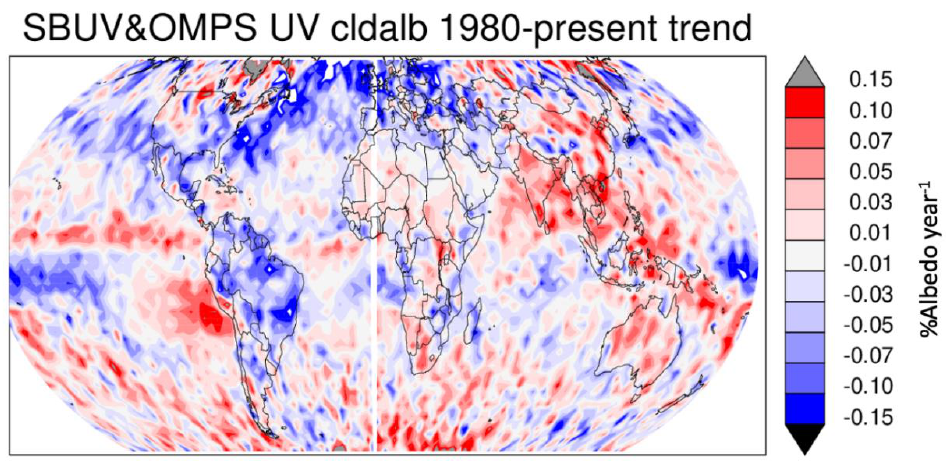
Figure 11. Map of UV BCA trends (1980–present) in % albedo year − 1 . Linear trends are determined for each 2° latitude by 3° longitude grid cell.